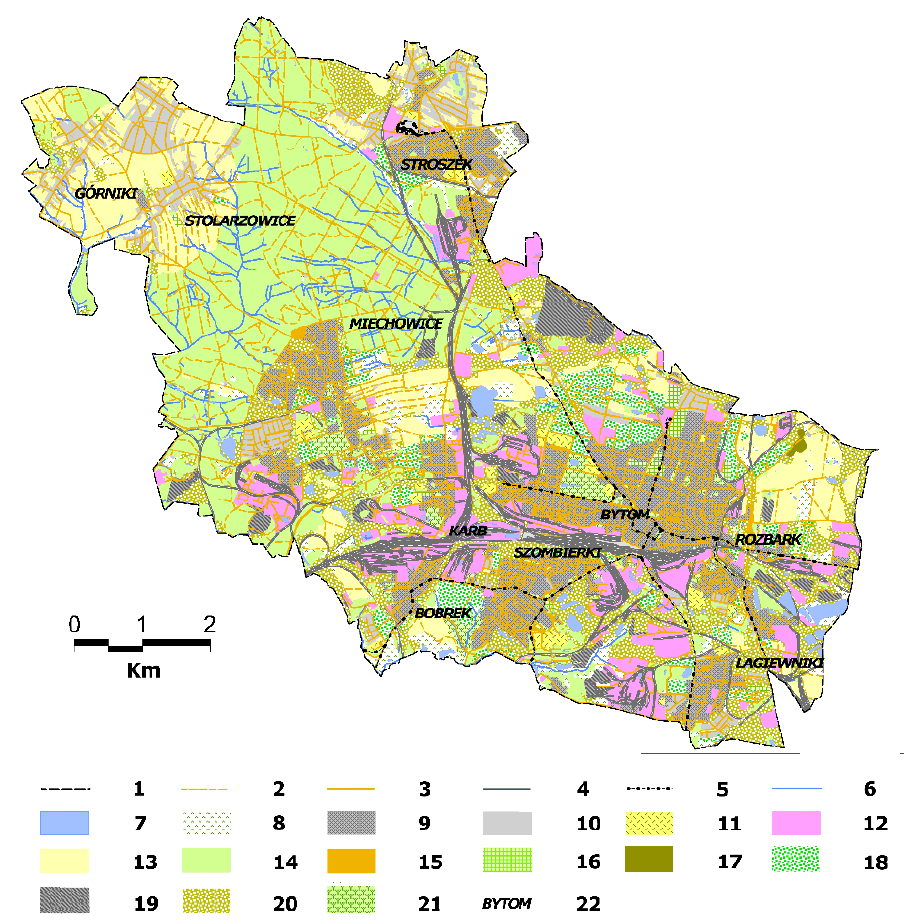
Figure 5. The land use of the area of Bytom in 1994 (Sourced by authors on the basis of Topographic map of Poland 1994, 1: 10,000, sheet: M-34-50-D-C-1 Wieszowa; M-34-50-D-C-2 Bytom–Stolarzowice; M-34-50-D-C-3 Zabrze–Mikulczyce; M-34-50-D-C-4 Bytom–Miechowice; M-34-50-D-D-1 Bytom–Radzionków; M-34-50-D-D-3 Bytom–Centrum; M-34-50-D-D-4 Piekary Ś l ą skie–Brzozowice Kamie ń ; M-34-62-B-A-2 Ruda Ś l ą ska–Ruda; M-34-62-B-B-1 Ś wi ę toch ł owice; M-34-62-B-B-2 Chorzów). Explanations: 1—current city border; 2—dirt roads; 3—paved roads; 4—railway lines; 5—